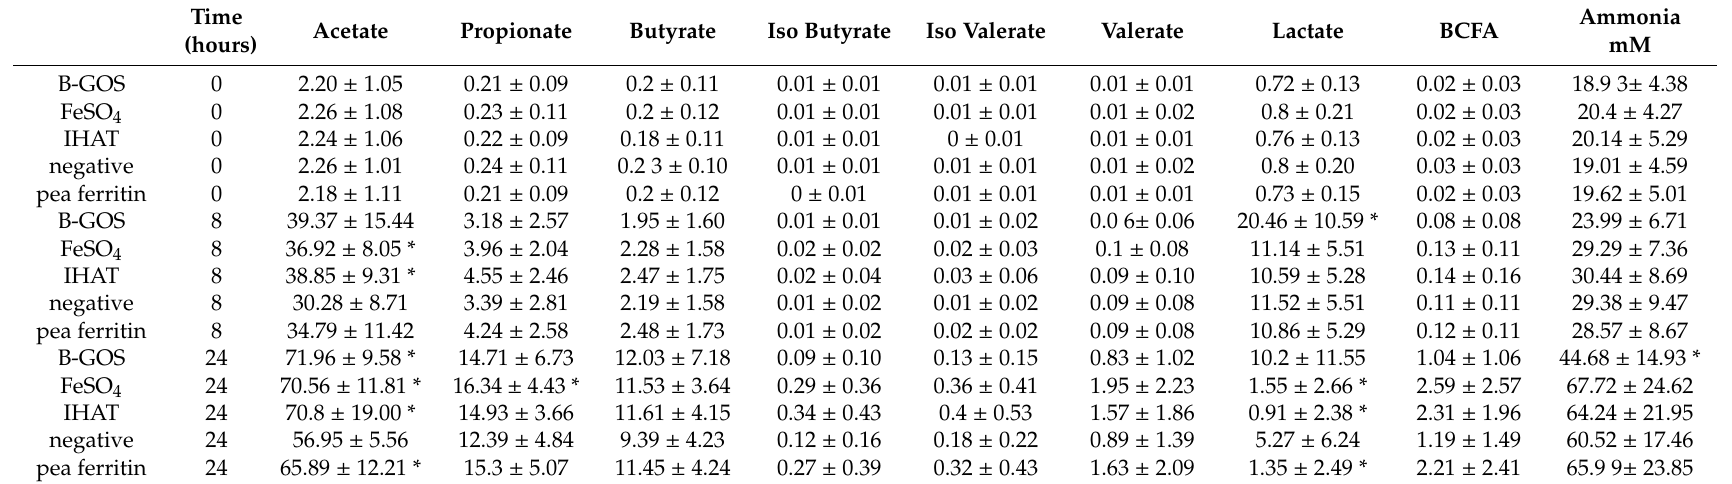
Table 2. Metabolite production at baseline (0 h), 8 and 24 h of fermentation in pH-controlled batch cultures inoculated with faeces from 15 donors (5 with IBS-D, 5 with IBS-C and 5 healthy controls, data